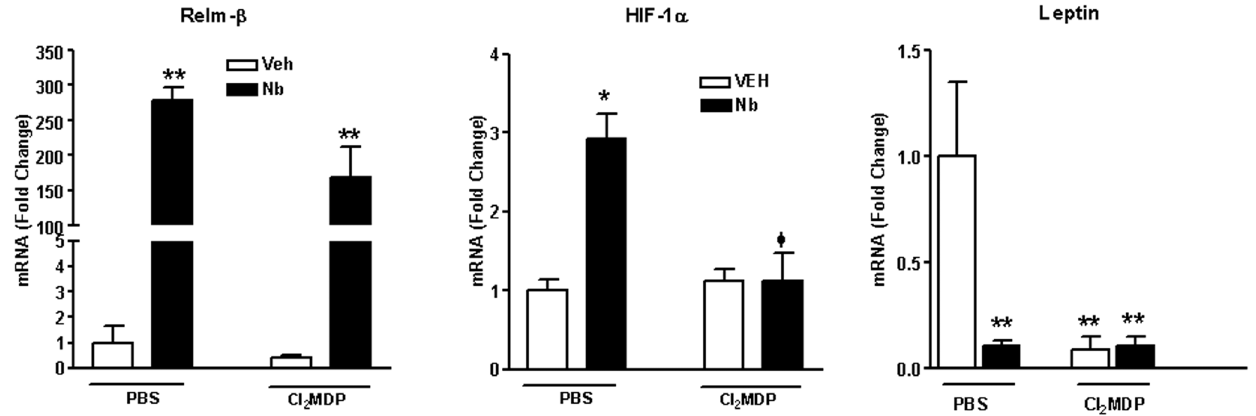
Figure 5. Macrophage depletion alters expression of factors involved in small intestinal glucose homeostasis. WT mice were given PBS or clodronate (Cl 2 MDP) containing liposomes to deplete macrophages and one day later treated with vehicle (VEH) or infected with N. brasiliens is (Nb). At day nine post-inoculation, full thickness sections of small intestine were prepared for real-time qPCR to determine the mRNA expression of RELM- b leptin, or HIF-1 a . Values shown are means 6 SE, *p , 0.01 vs. VEH Control; Q p , 0.05 vs N. brasiliensis -infected mice treated with PBS- containing liposomes.